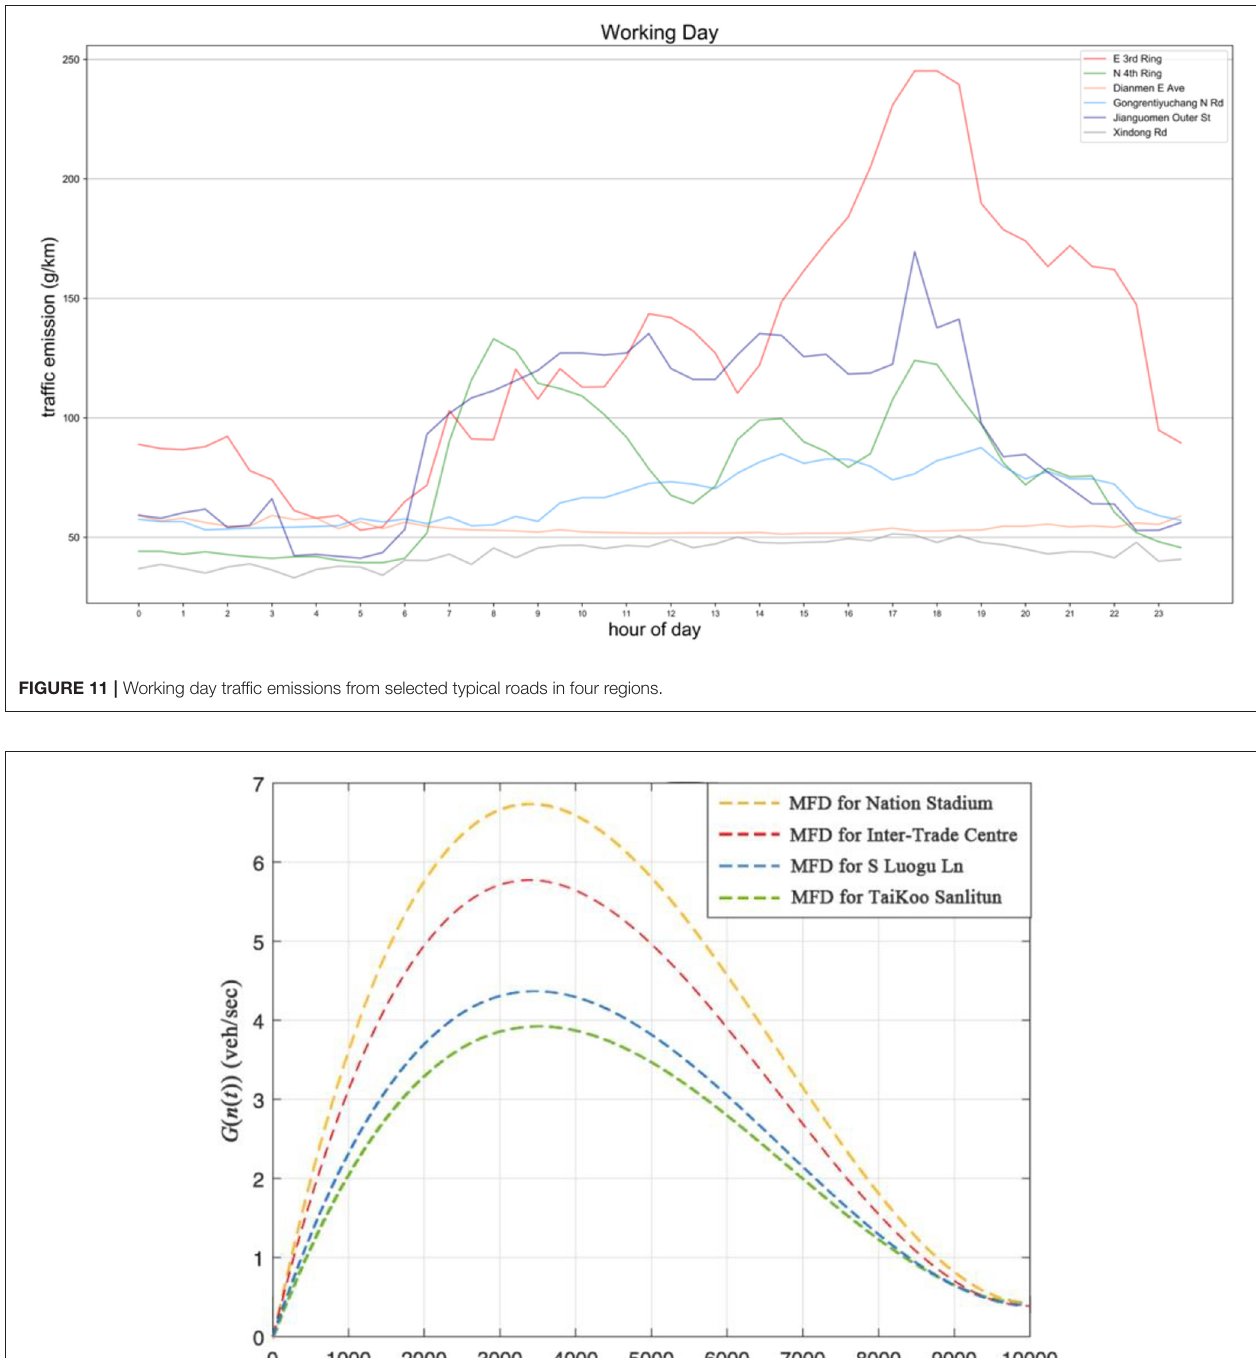
(including the areas outside the control areas), the speed during peak hours cannot be increased to the level of off-peak hours. From the emissions and energy consumption results ( Figure 10